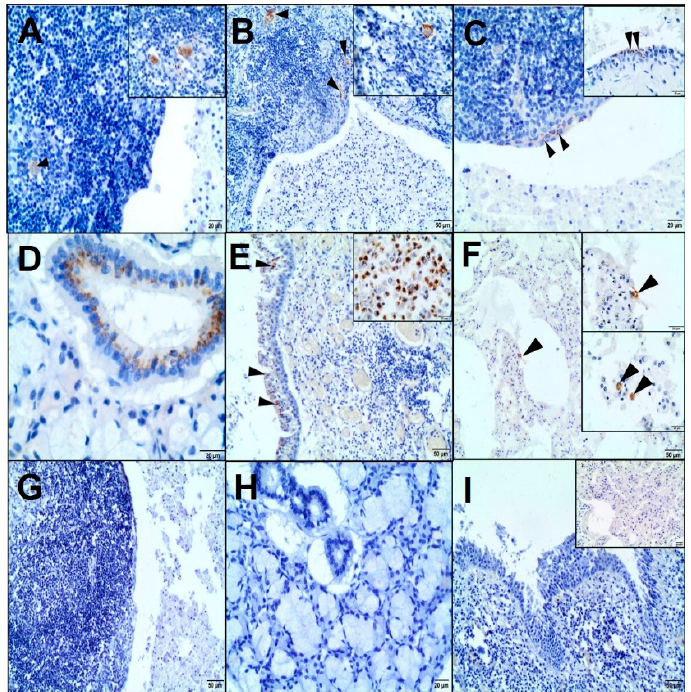
Figure 3. Immunohistochemical examination of the caprine arthritis-encephalitis virus (CAEV) in the LEC, salivary gland, and lungs. ( A ) The positive staining of CAEV (cytoplasmic) in macrophages and macrophage-like cells in the lymphoid follicles (arrowhead), 200 × ; scale bar = 20 µ m. Inset, 400 × ; scale bar = 20 µ m. ( B ) Additionally, in the peripheral lymphoid region (arrowheads), 100 × ; scale bar = 50 µ m. Inset, 400 × ; scale bar = 20 µ m. ( C ) The cytoplasm of the epithelial cells lining the cyst slightly immunostained with CAEV (arrowheads), 200 × ; scale bar = 20 µ m. Inset, 400 × ; scale bar = 20 µ m. ( D ) The immunostaining of CAEV (cytoplasmic, in the perinuclear region) in the epithelial cells of the salivary duct, 400 × ; scale bar = 20 µ m. ( E ) CAEV-positive bronchial epithelial cells (cytoplasmic, perinuclear staining; arrowheads), 100 × ; scale bar = 50 µ m. Inset: CAEV-positive macrophages in the peribronchial inflammatory cell infiltration, 400 × ; scale bar = 20 µ m. ( F ) A few CAEV-positive macrophages scattered in the interstitial tissue and alveolar lumen, 100 × ; scale bar = 50 µ m. Inset 400 × ; scale bar = 20 µ m. ( G – I ) No specific staining was observed in the negative controls. ( G ) LEC, 100 × ; scale bar = 50 µ m. ( H ) Salivary gland, 200 × ; scale bar = 20 µ m. ( I ) Lungs, 100 × ; scale bar = 50 µ m. Inset, 200 × ; scale bar = 20 µ m.